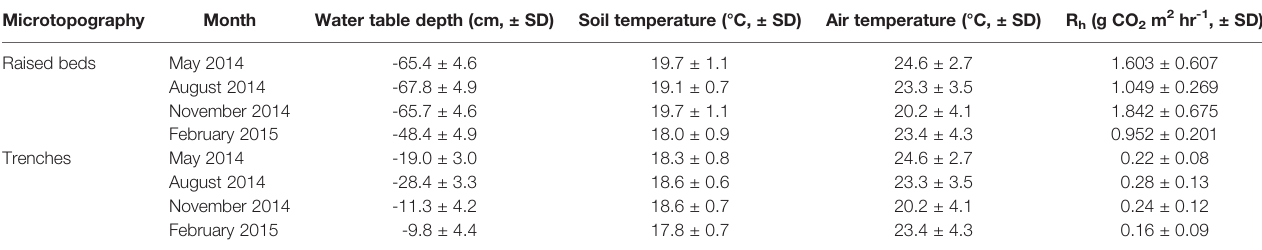
TABLE 3 | The average results and standard deviation from all measurements each month, separated into results from raised beds and